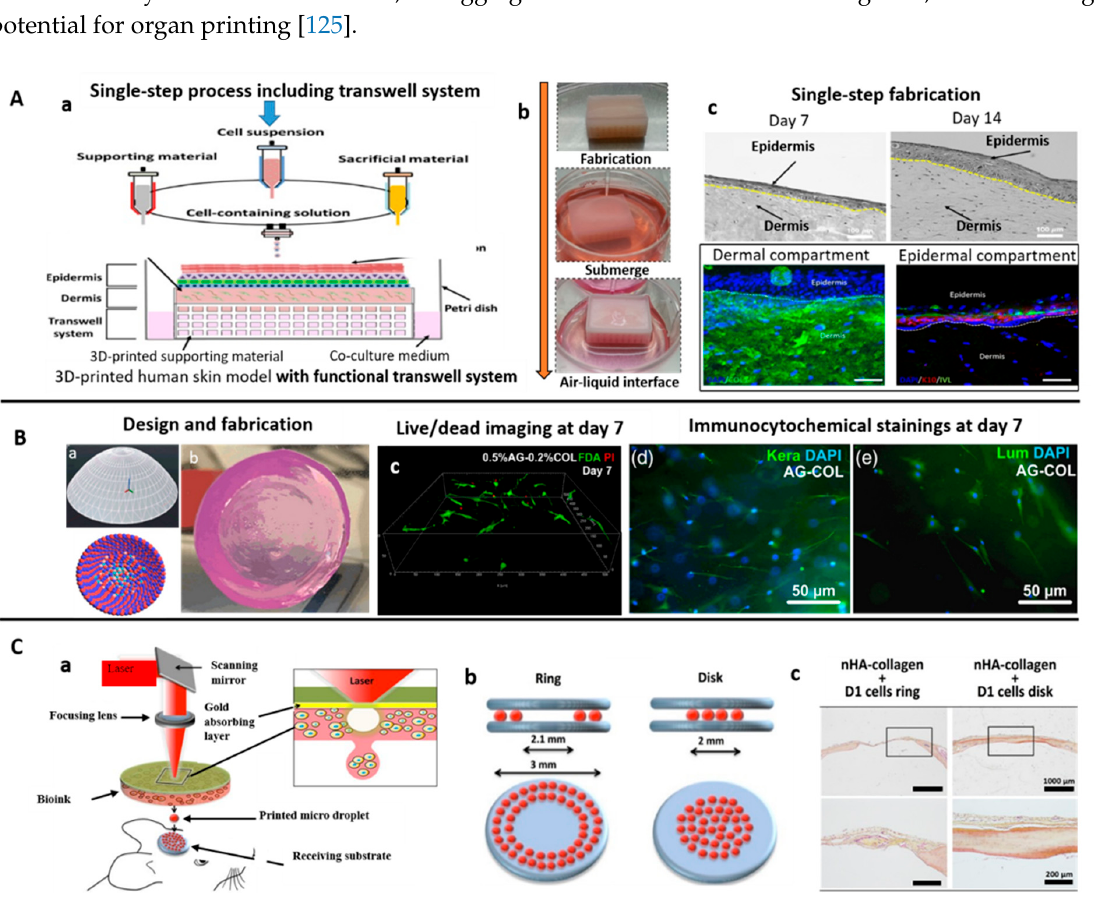
Figure 2. Bioprinting of collagen-based inks for tissue engineering . ( A ) (a,b) Hybrid system (extrusion-based and inkjet-based dispensing modules) used for bioprinting of collagen bioink for developing human skin models, (c) bioprinted model showed good structural features and respective dermis (Col) and epidermis (K10) biomarkers [118]; ( B ) (a,b) Drop ‐ on ‐ demand (DoD) bioprinting was used for bioprinting collagen bioink to develop functional biomimetic 3D corneal model, (c) 3D view of human CSK 7 days after bioprinting stained with live/dead staining, most of cells found viable, (d) Smooth muscle actin immunocytochemical stainings of CSK ‐ loaded agarose ‐ collagen blends 7 days after bioprinting, observed positive keratocan (Kera) and lumican (Lum) expression [120]; ( C ) (a) Laser-assisted bioprinting was explored for in-situ bioprinting of collagen-based bioinks for bone regeneration applications, (b) two different printed designs: a ring and a disk, and (c) disk printed geometry showed homogeneous regeneration throughout the defect, in contrast with the ring geometry, where regeneration is mainly observed at the periphery